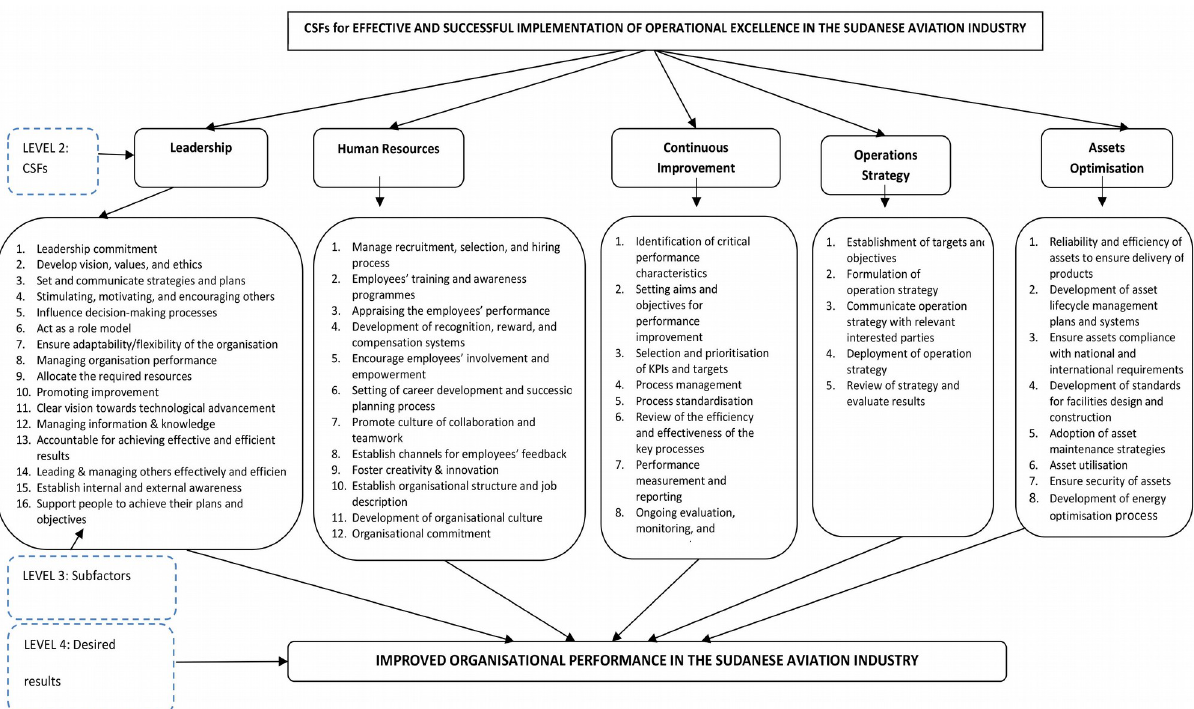
Figure 1. The Initial AHP Structure for OE in the Sudanese Aviation